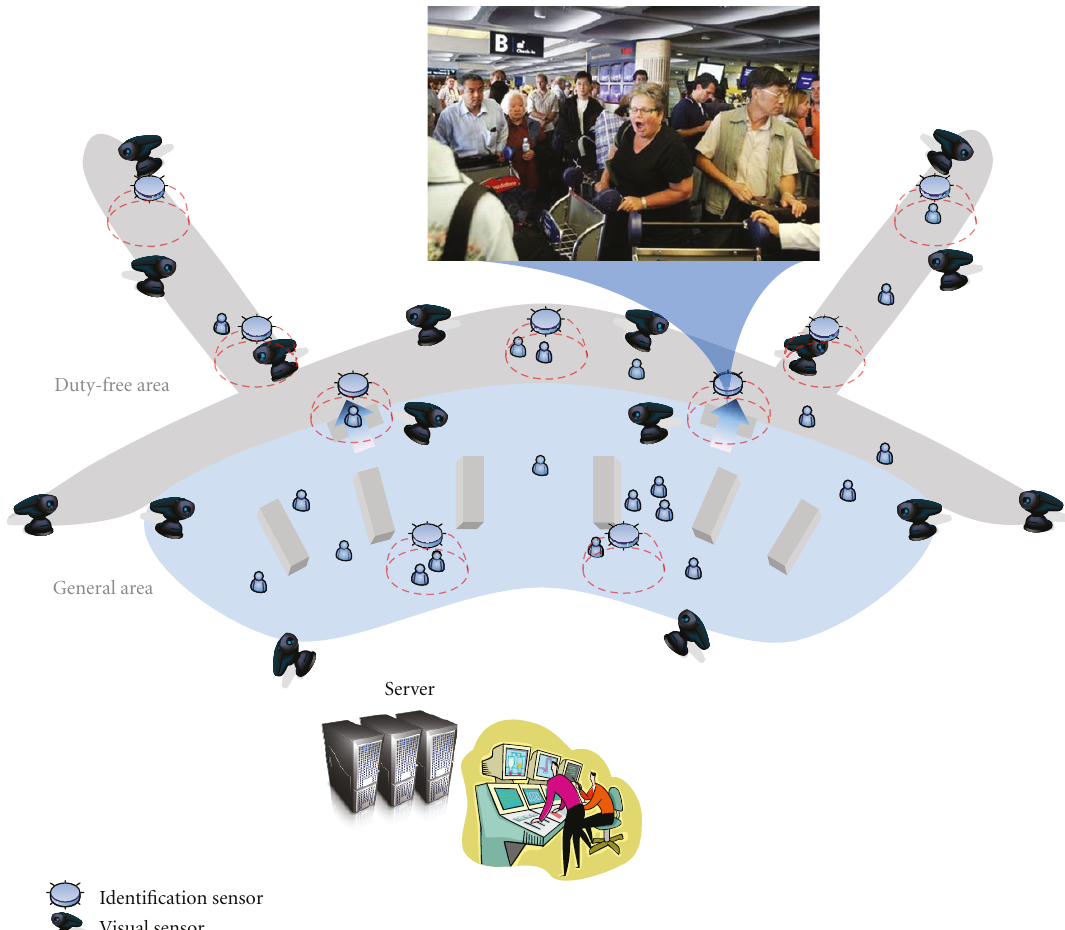
Figure 1: Example of an application model with heterogeneous sensors of visual sensors and identification